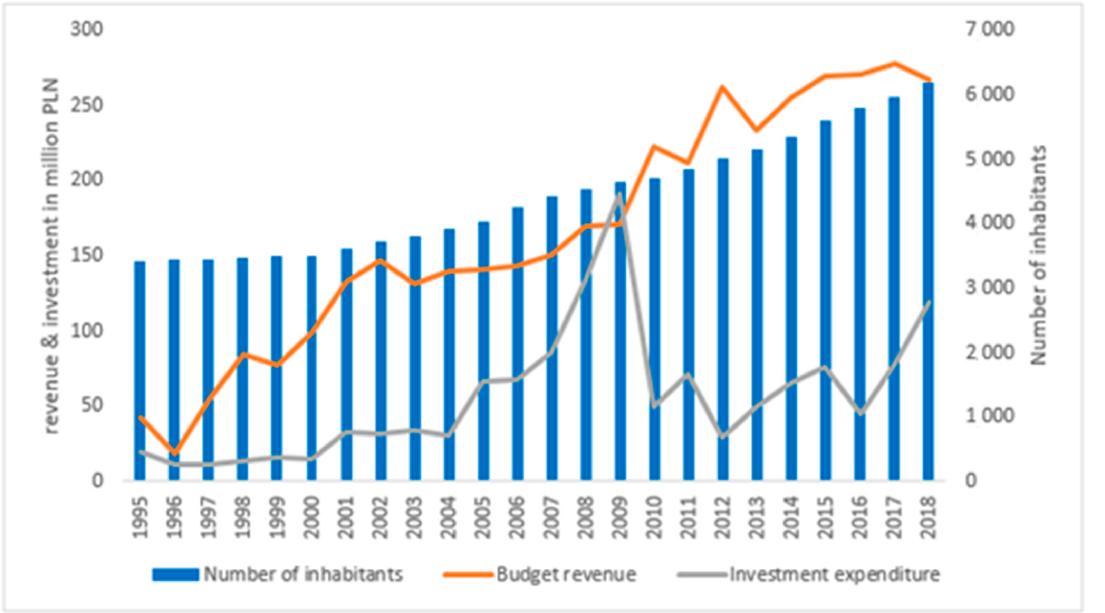
Figure 5. Budget revenue, investment expenditure (in millions of PLN), and population of the Kleszczów municipality in 1995–2018 (Source: own elaboration based on data from the Central Statistical Office and the Municipality).